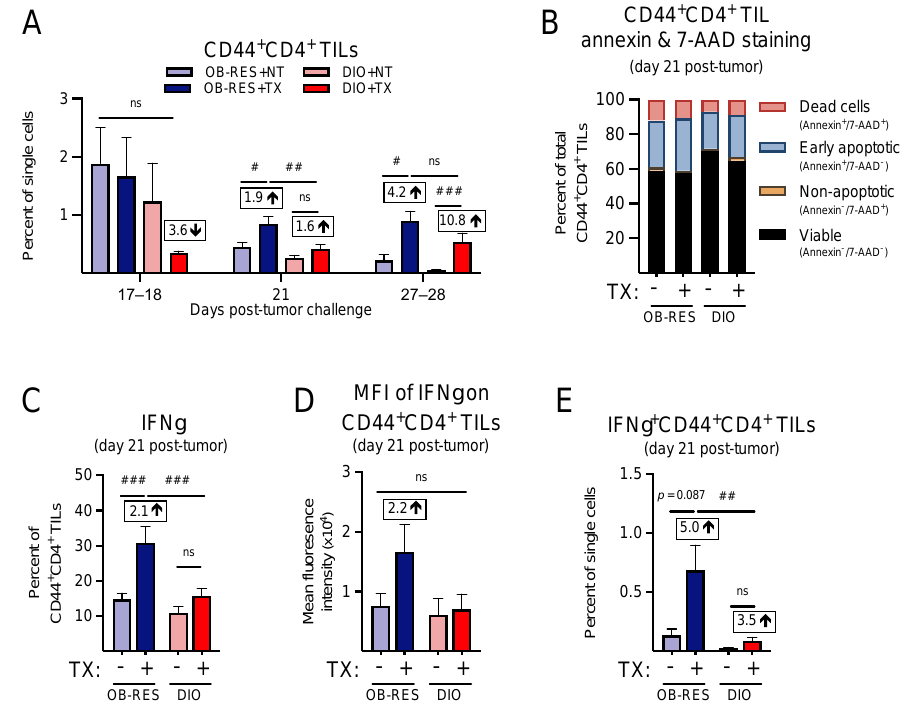
Figure 5. Therapy-treated OB-RES mice have a robust CD4 + TIL effector response that is lacking in DIO mice. ( A ) CD44 + CD4 + TILs at day 17–18, day 21, and day 27–28 post-tumor challenge across groups. ( B ) Cell viability and death markers at day 21 post-tumor challenge in CD44 + CD4 + TILs. ( C ) Intracellular expression of IFN γ and ( D ) the mean fluorescent intensity of IFN γ in ex vivo stimulated CD44 + CD4 + TILs at day 21 post-tumor challenge. ( E ) IFN γ + CD44 + CD4 + TILs as a percent of single cells at day 21 post-tumor challenge. Data from n = 2–5 independent experiments. Fold change value calculated using no therapy control for each group. # denotes non-parametric test. # p < 0.05, ## p < 0.01, ### p < 0.001. ns: non-significant, NT: no therapy, TX: AdT/CpG+ α